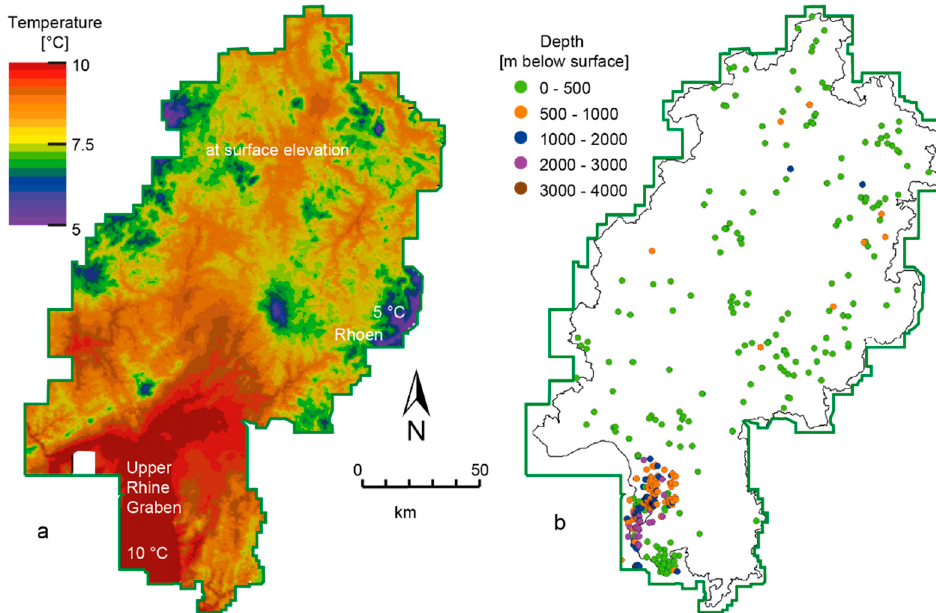
Figure A1. Temperature data; ( a ) applied Dirichlet boundary conditions for temperature at the top (annual mean temperature, [50]); color code indicates temperature from purple low temperatures to red high temperatures, maxima and minima are declared in white; ( b ) overview on the spatial distribution of temperature measurements taken from boreholes within different depths. Deepest boreholes are in Cenozoic units in the Upper Rhine Graben.